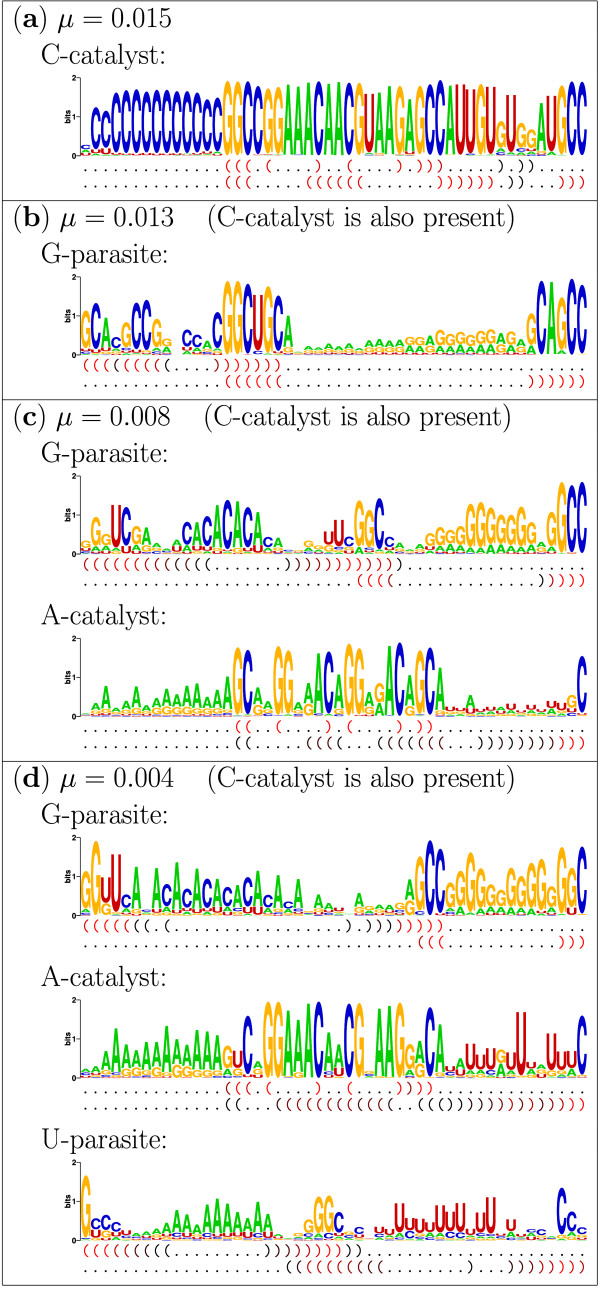
Sequence logos and typical secondary structures for each sequence classes. Genotypes were categorized into sequence classes through the phylogenies shown in Fig. 2 (see Methods for mode details). Sequence logos were produced by using WebLogo [45]. The typical secondary structures were produced as follows. For a set of aligned structures represented by dot-bracket notation, the frequencies of bound and unbound bases (i.e., '(', ')' and '.') are counted for each structure position. For each position, if the frequency of '(' or of ')' exceeds 20%, then the corresponding bracket is drawn; otherwise, '.' is drawn. The color of the brackets represents its frequency: the more frequent, the more red. Physical complexity C [40] was calculated from the sequence logos (see Discussion for details). For μ = 0.004, CC = 41.3 for the C-catalyst; CG = 22.5 for the G-parasite; CA = 26.5 for the A-catalyst; CU = 13.0 for the U-parasite; and C∀ = 13.4 if all sequence classes are grouped together. For μ = 0.008, CC = 41.5; CG = 19.9; CA = 20.9; and C∀ = 15.7. For μ = 0.013, CC = 37.9; CG = 21.0; and C∀ = 27.5. For μ = 0.015, CC = 38.2 (CC = C∀ by definition).